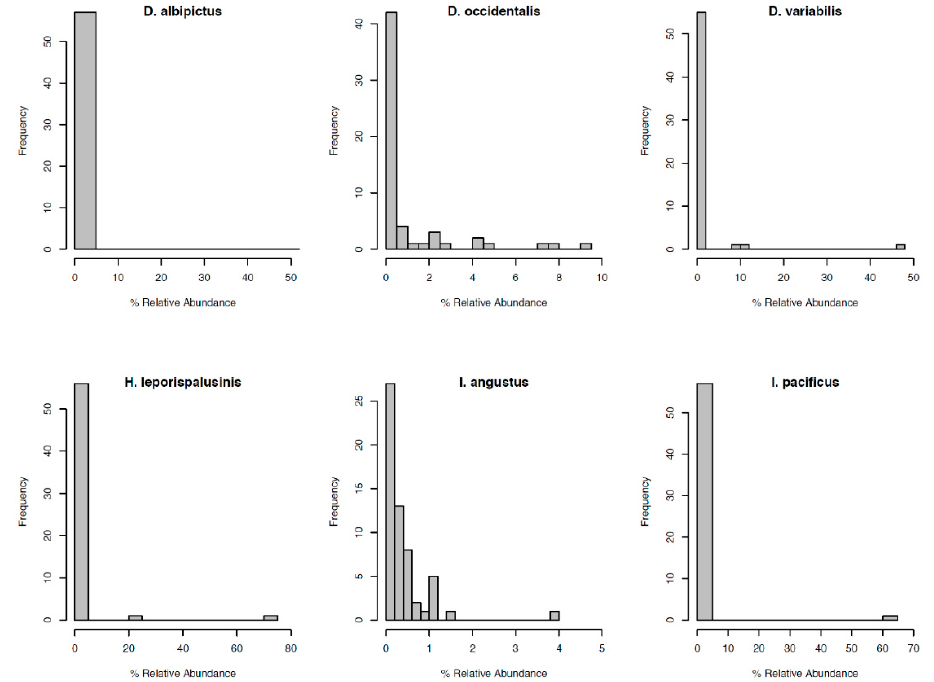
Figure 3. Distribution of OTU relative abundance for each species’ microbiome. The x -axis denotes the percentage of sequence reads attributed to a given OTU. The y -axis denotes the number of OTUs occurring at a given relative abundance.